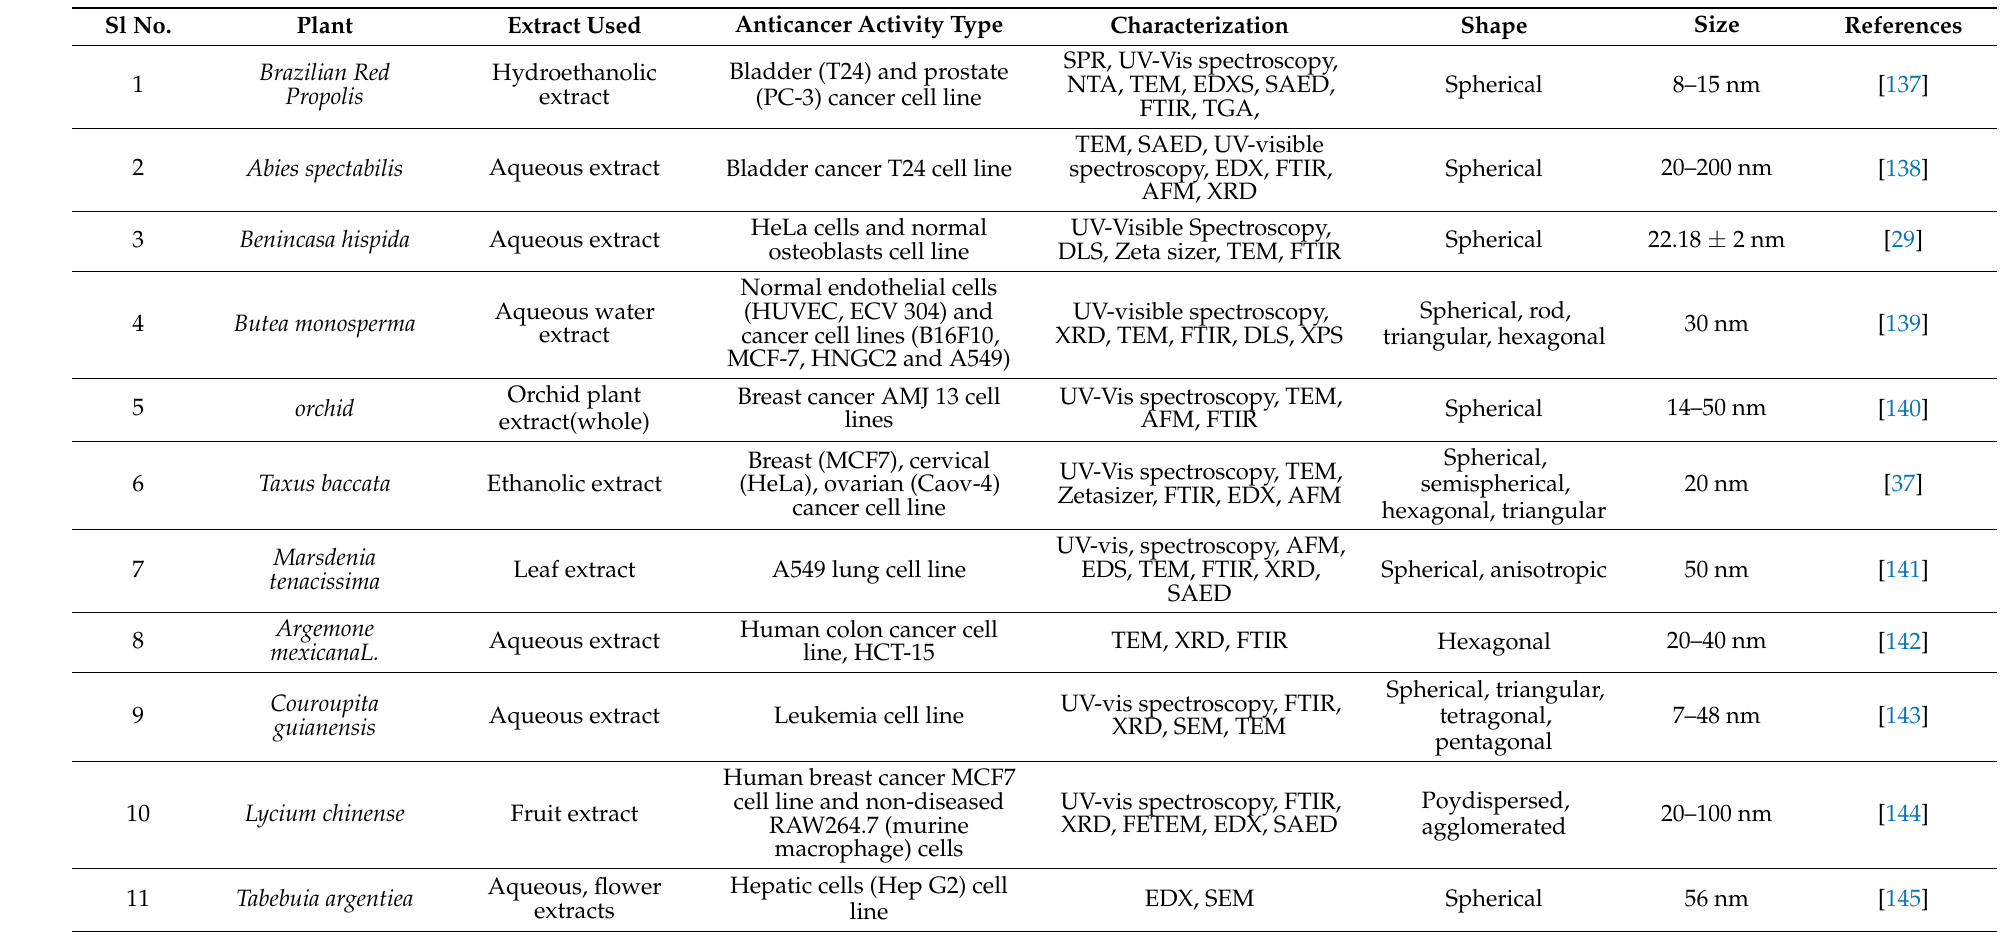
Table 3. Showing anticancer activity of gold nanoparticles using plant extracts and characterization